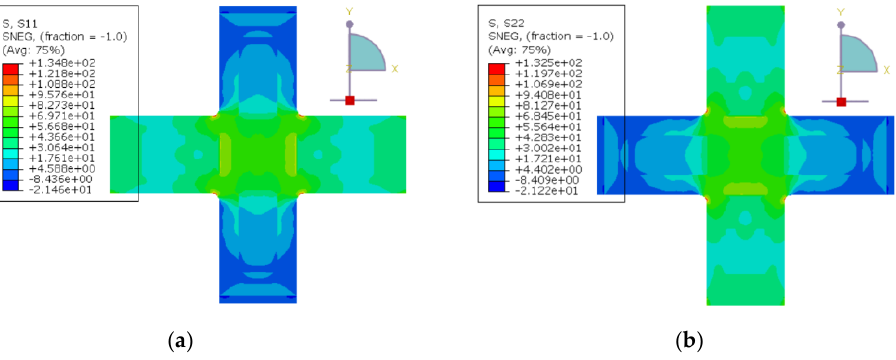
Figure 12. Stresses of the finite element model. ( a ) S11 stresses. ( b ) S22 stresses. The stress and strain at the center point under different tensile forces were collected and drawn onto a three-dimensional curved surface, which was compared with the experimental data and the optimized theoretical value, as shown in Figure 13. The experimental data refers to the data obtained by the biaxial tensile test. Simulation surface refers to the surface which was simulated by parameters obtained by the calculation method proposed in this study and the finite element software. The value of optimization theory refers to values obtained using experimental data and the calculation method proposed in this study.